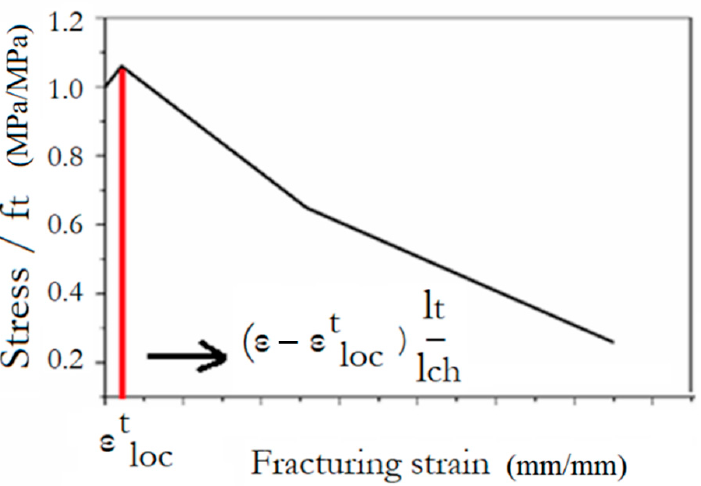
Figure 10. Constitutive modelling for UHPFRC depending on the FEA mesh size.